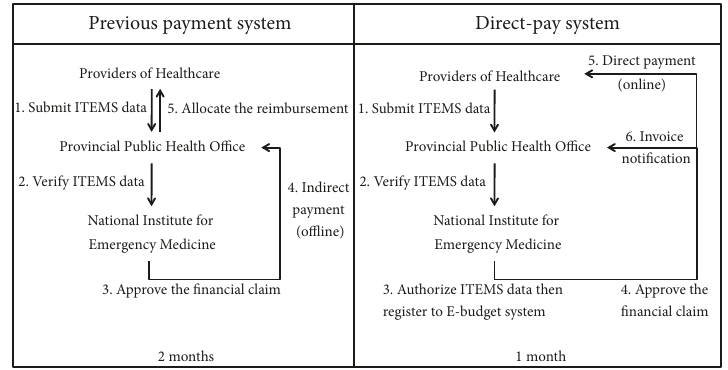
Figure 1: A comparison between the data flows of previous payment system and direct-pay system.